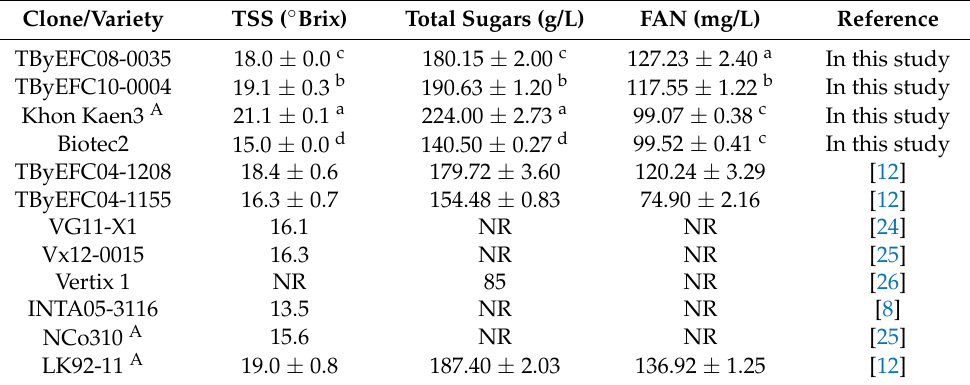
Figure 1. Sucrose, glucose and fructose contents ( a ) and percentage ratio of sugar ( b ) in juice from energy cane clones and control varieties. Table 1. Chemical composition of juice from energy cane clones and control shown in Table 2. The contents of cellulose, hemicellulose and lignin of the two energy